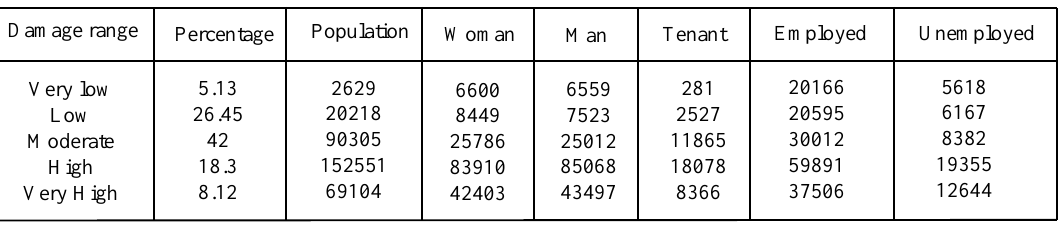
Table 5. Sanandaj Social vulnerability based on the MCDA-RBFNN hybrid model.